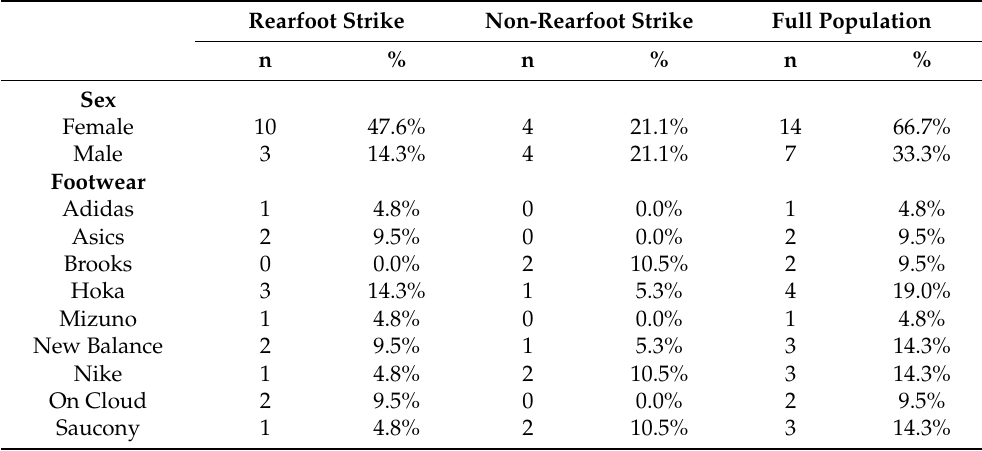
Table 1. Twenty-one participants completed the study procedures with sex, footwear and foot strike breakdown below. Foot strike was determined from visual inspection and center of pressure data.